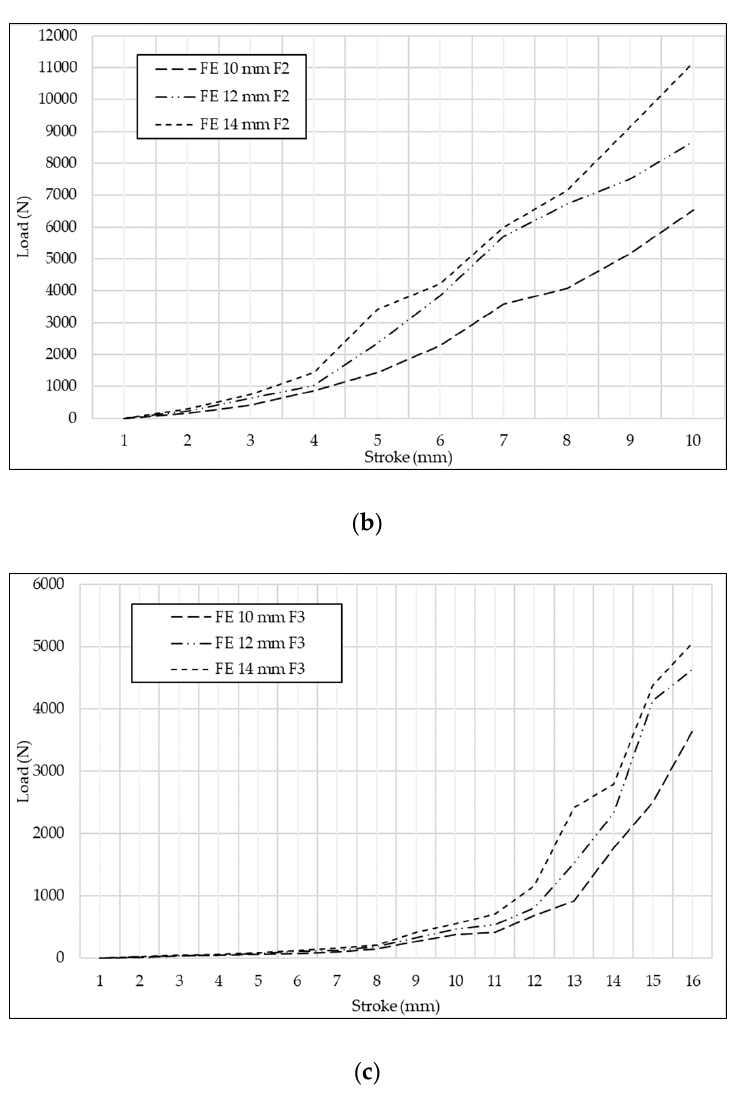
( b ) ( c ) Figure 15. Comparison of load between simulations and experiments ( a ) form1; ( b ) form2; ( c ) form3.